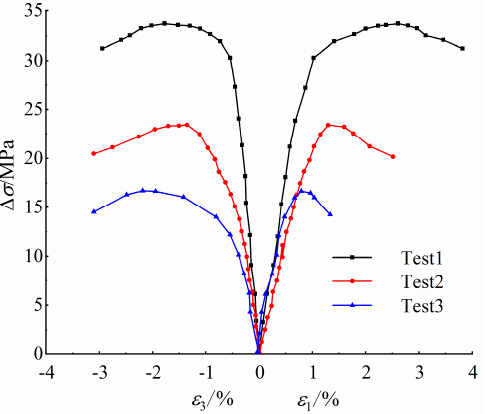
Figure 5. Stress–strain curves of specimens under different test paths.